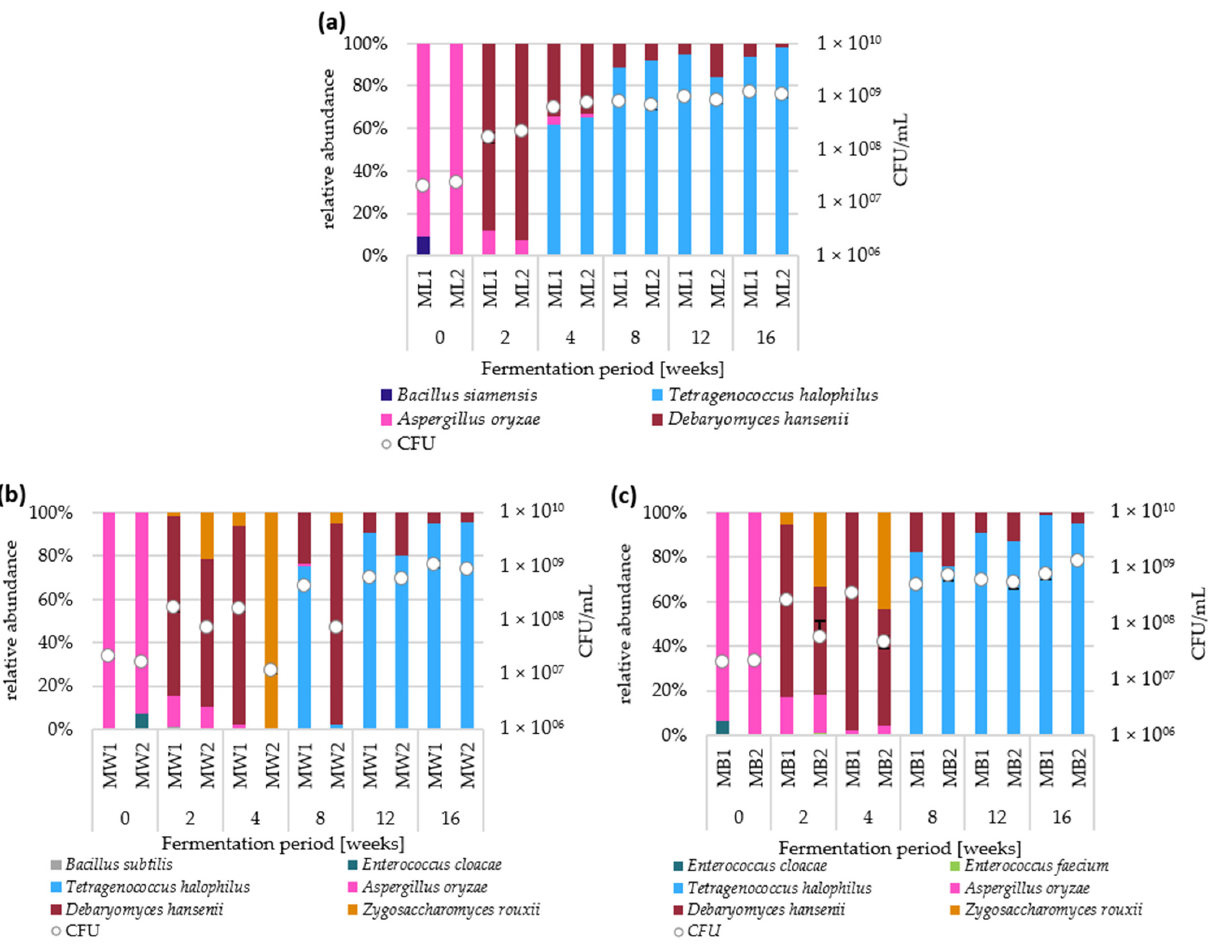
Figure 2. Microbiota dynamics during moromi fermentation, incubated for four days on ME agar at 30 ◦ C via MALDI-TOF-MS. Species and CFU/mL (white dots) in moromi fermentation with ( a ) Lupine seeds as sole substrate, with ( b ) wheat and ( c ) buckwheat. Error bars indicate the standard deviation from